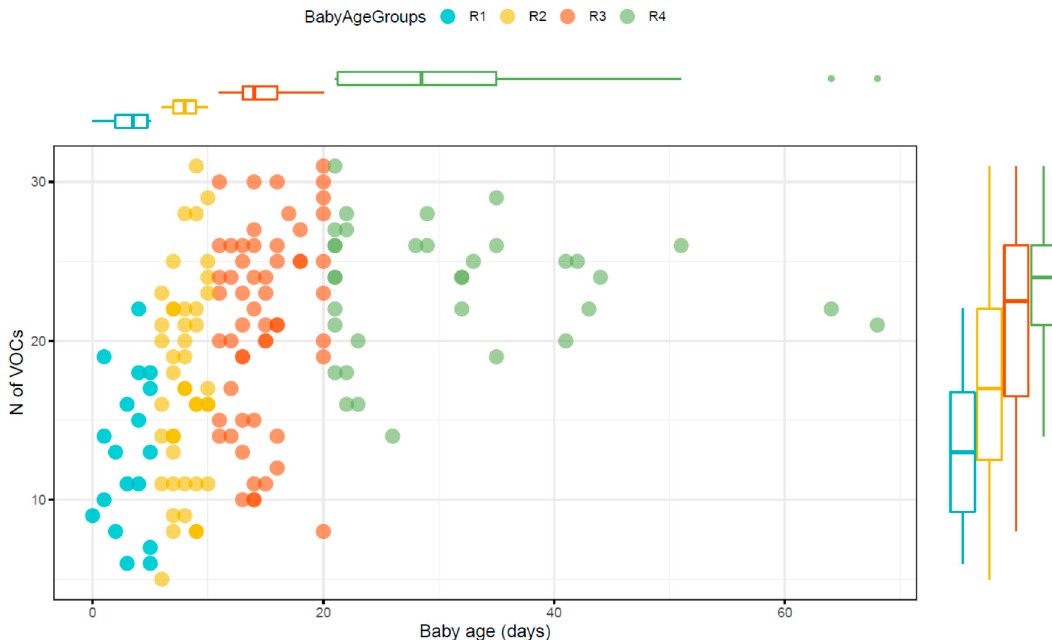
Figure 1. Scatterplot and boxplots to show the number of volatile organic compounds (VOCs) in each of the age groups. Each dot represents a sample (all samples were included, n = 152). (R1 = up to 5 (n = 18), R2 = 6–10 (n = 44), R3 = 11–20 (n = 56), R4 = 21–70 days (n = 34).